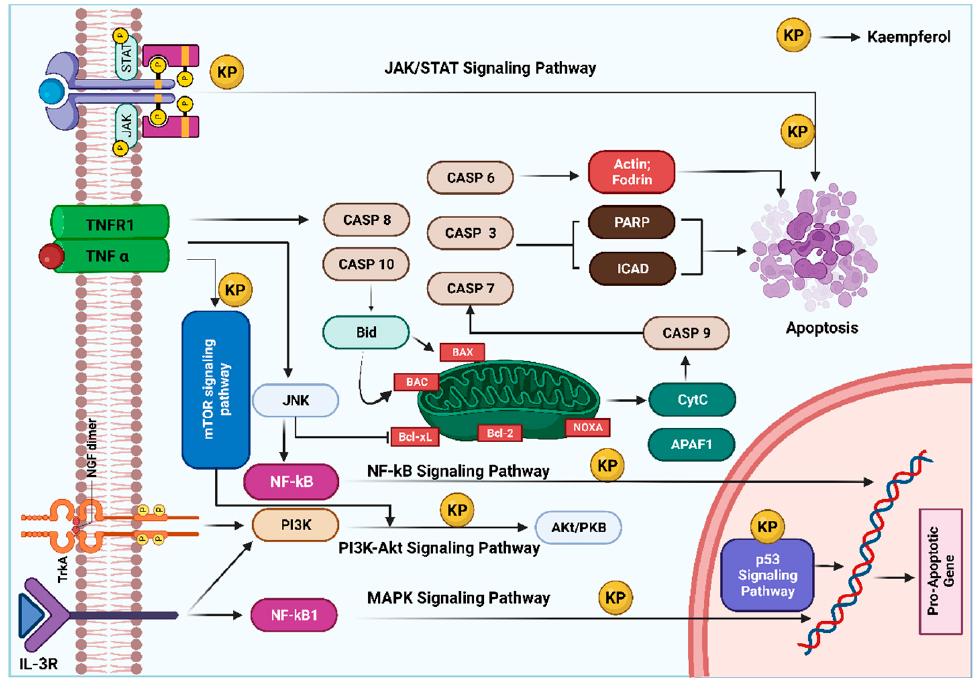
Figure 3. Anticancer role of kaempferol: at a molecular level, this compound is able to exert anti- cancer effects primarily by reducing the levels of proteins involved in the development and pro- gression of cancer. This is accompanied by induction of apoptosis, arrest of the cell cycle, and downregulation of anti-inflammatory proteins. In addition, different molecular signaling pathways and mitochondrial mechanisms are involved in the activation of tumor cell apoptosis by kaempferol. The illustration is adopted with modifications from Amjad et al. [30]. Created with Biorender.com (accessed on 10 April